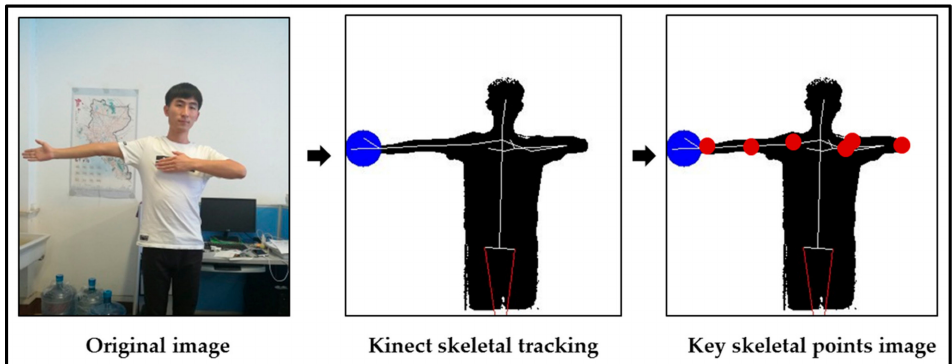
Figure 3. The acquisition process of key skeleton point positions from Kinect